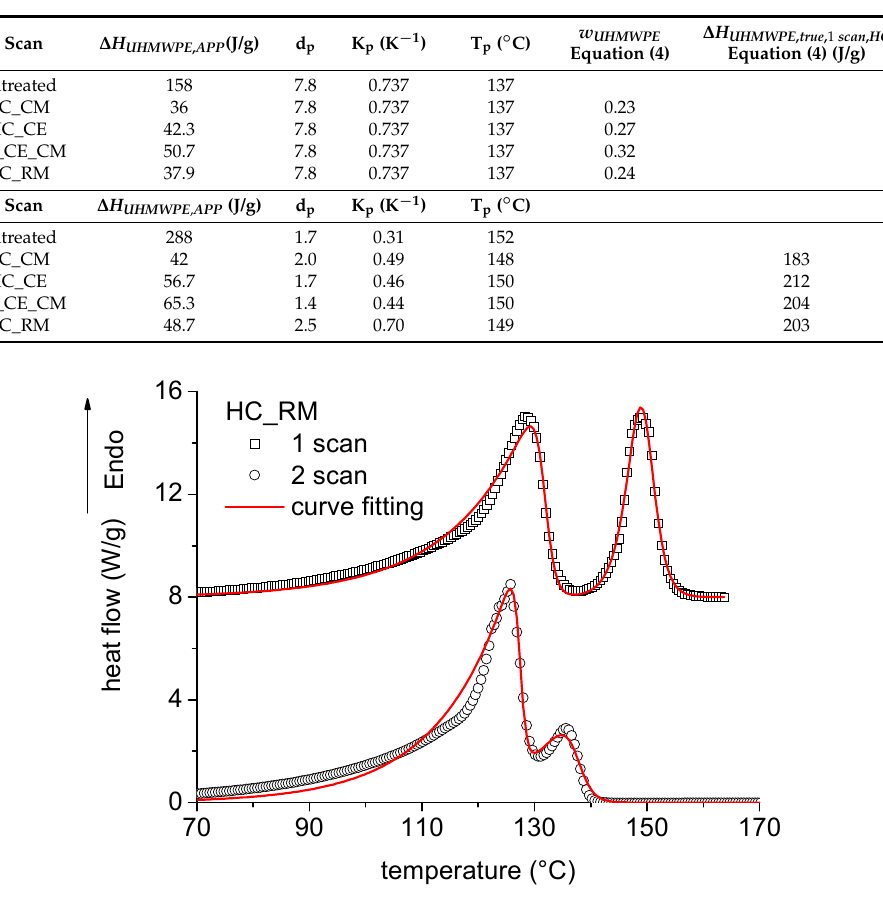
Table 2. Thermal properties of polyethylene homo-composites.